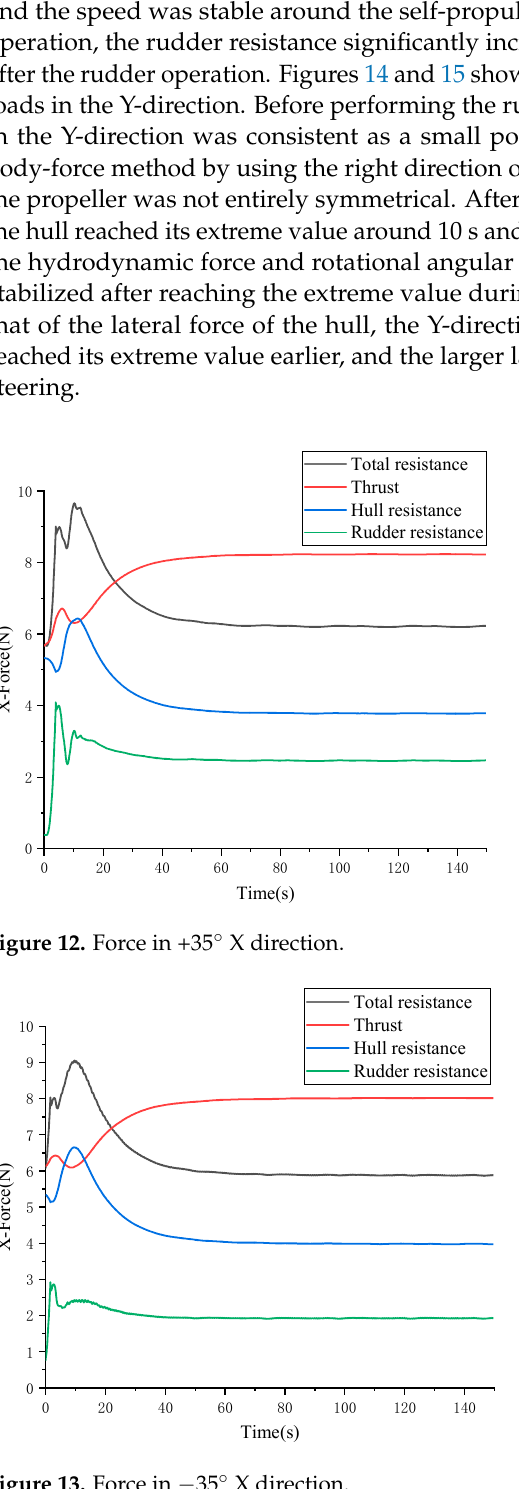
Figure 14. Force in +35° Y direction.